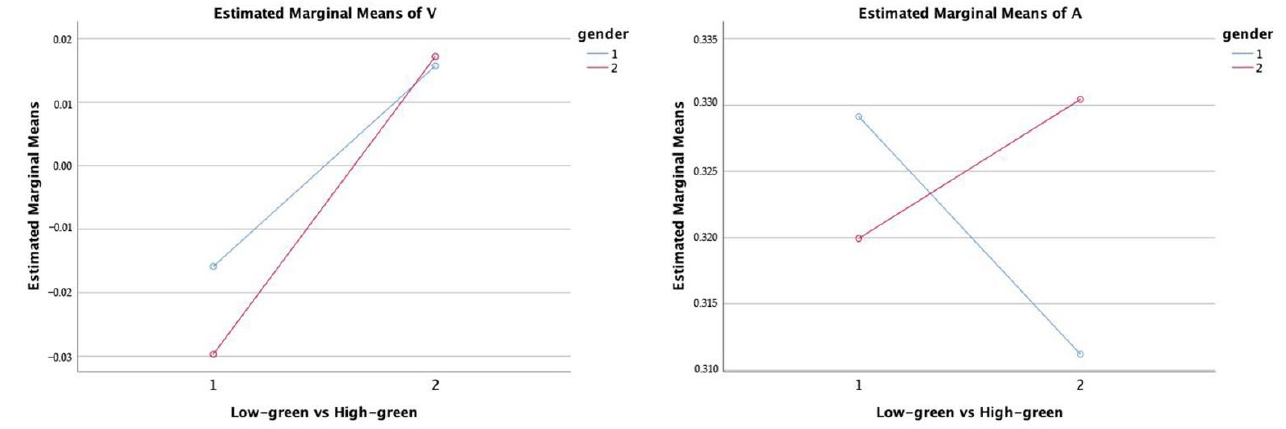
Figure 8. The gender differences in the perception of different amounts of green in a scene. The “Low-green vs. High-green” indicates two scenes: (1) low-green; (2) high-green. The “gender” indicates two genders: (1) men; (2) women.